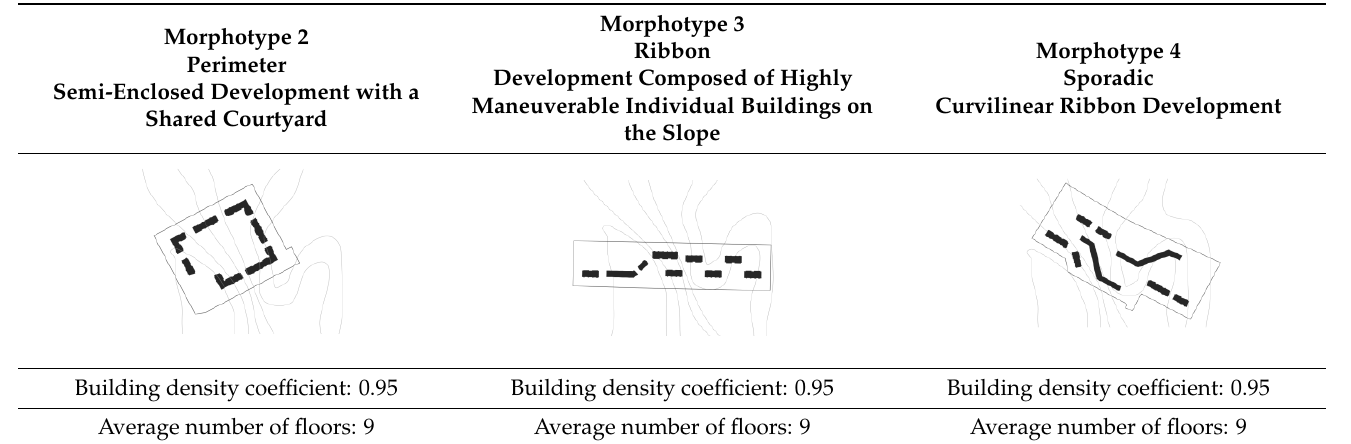
Table 3. Models used in the theoretical study of the aeration regime of residential development on the sloping lands of the AZRF.